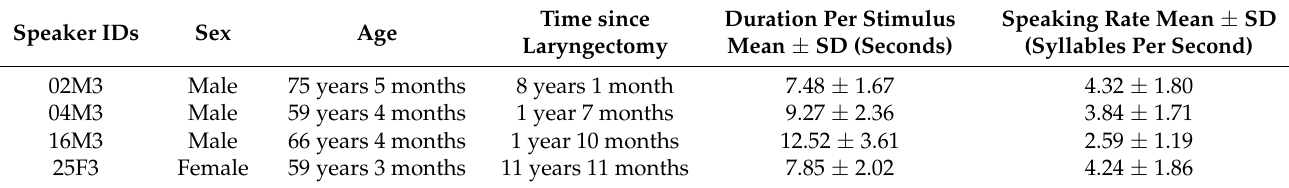
Table 1. Speaker characteristics.